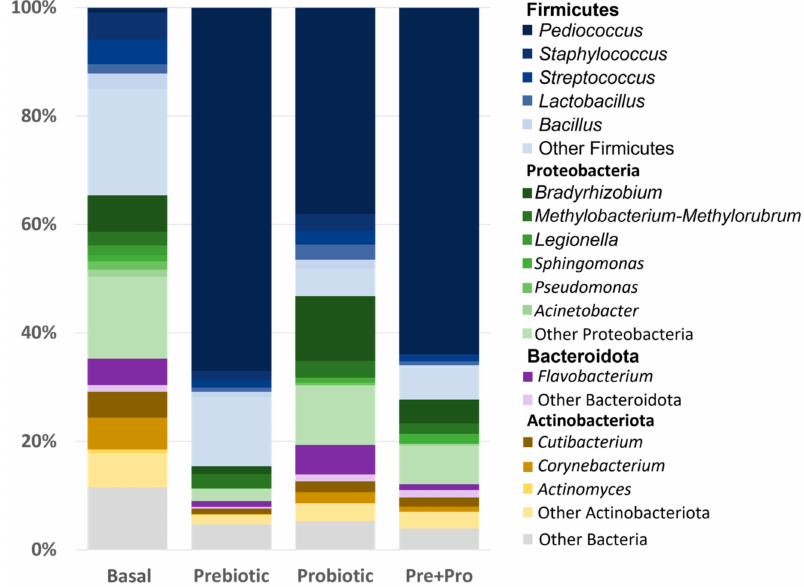
Figure 4. Average relative abundance of bacterial genera in red drum digesta. All samples were found to be predominantly composed of bacteria from four phyla: Firmicutes, Proteobacteria, Bacteroidota, and Actinobacteriota.